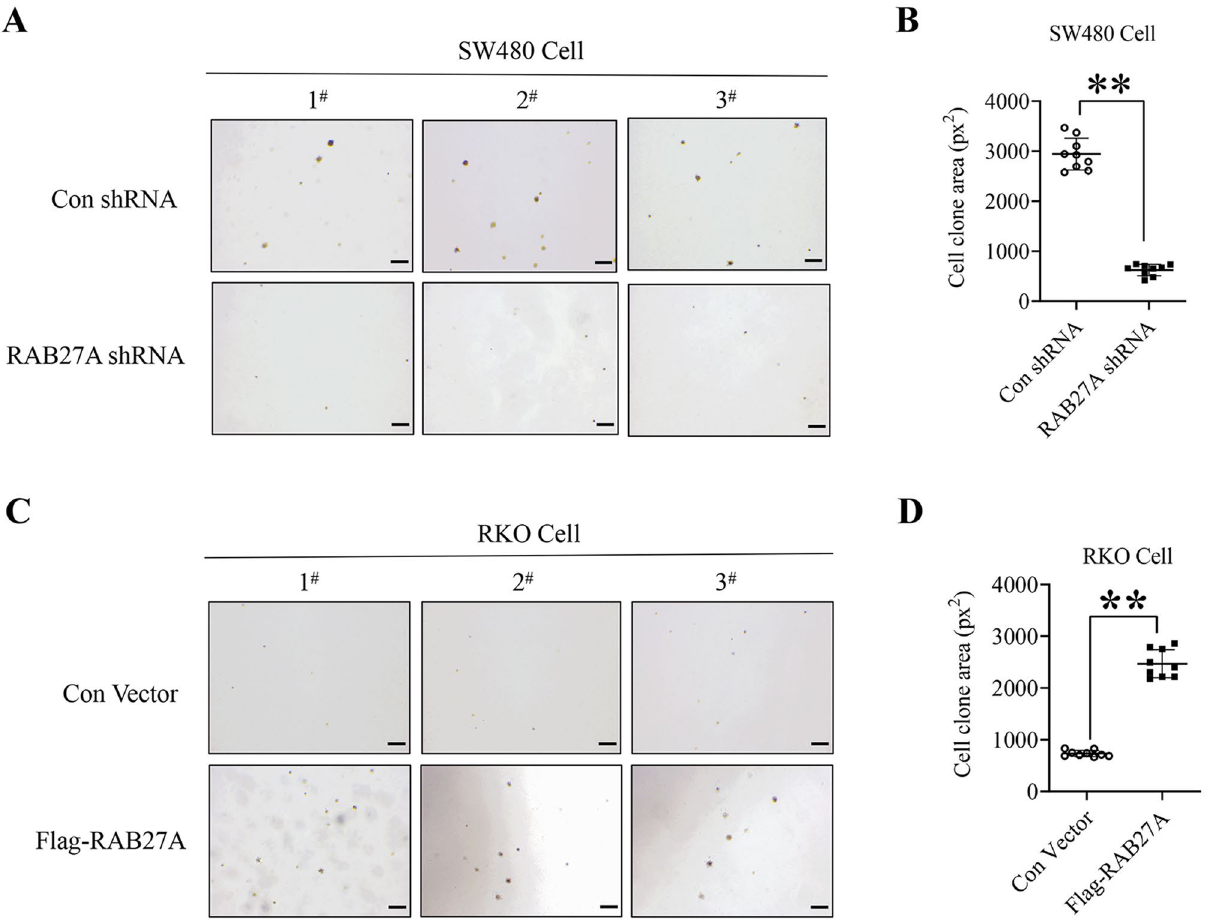
Figure 3. The effect of RAB27A on clone formation of colon cancer cells. ( A ) and ( B ). RAB27A knockdown inhibits clone formation of SW480 cells. RAB27A knockdown and the negative control SW480 cells were mixed with the melting agarose gel and plated in 6-well plates for 4 weeks, and cell clones were determined by microscopy (4 ×). ( C ) and ( D ). RAB27A overexpression promotes clone formation of RKO cells. The RAB27A overexpression and the negative control RKO cells were mixed with melting agarose gel and plated in 6-well plates for 4 weeks, and the cell clones were determined by microscopy (4 ×). At least three fields in each group were observed and the representative images were shown (scale bar = 200 µm). The area of cell clones was measured by using image J software, and was analyzed by two-tailed t-test. ** P < 0.01. px 2 , the square of pixels. All the experiments were repeated three times independently and the representative results were